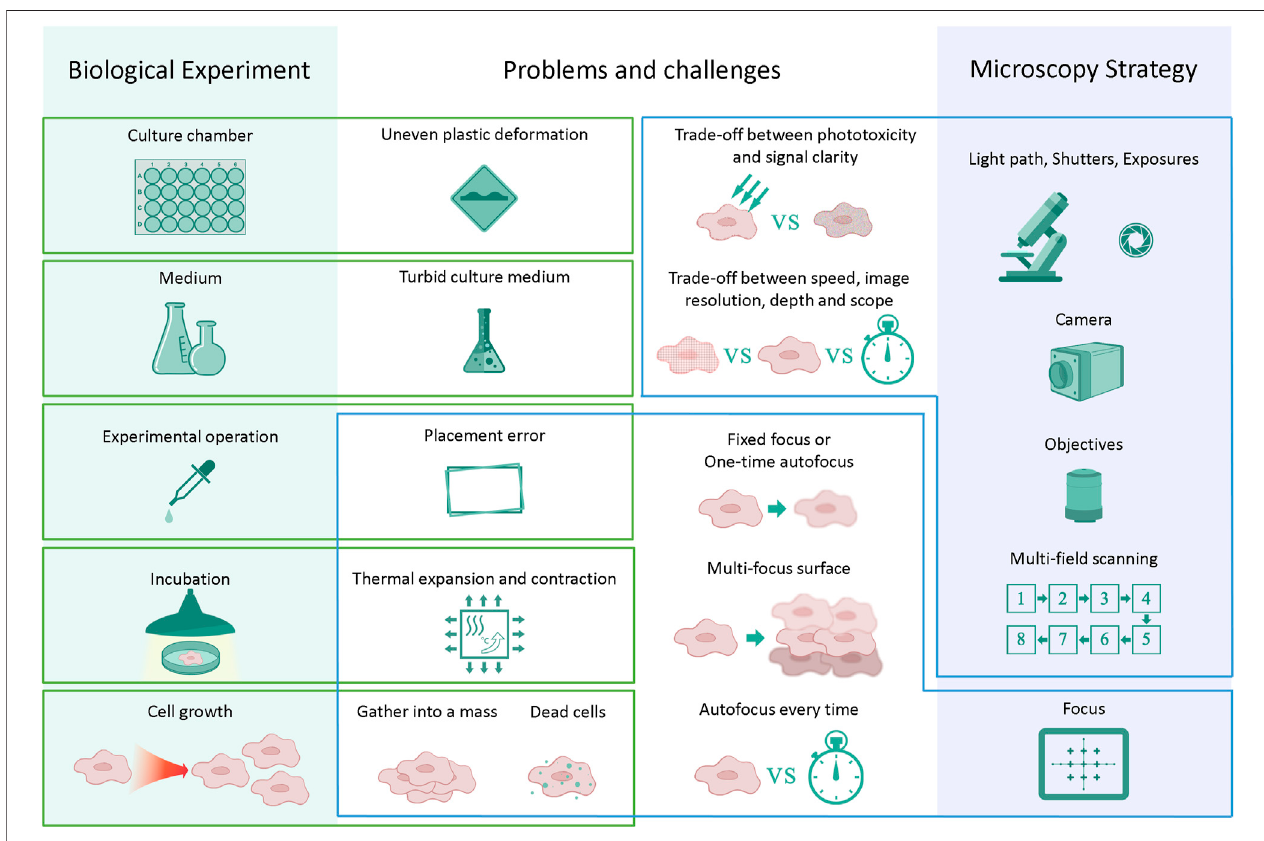
FIGURE 2 | Challenges in long-term live-cell imaging. Changes in individual steps or components may in fl uence the next series of steps and cause a reduction in image quality. Trade-offs must be made between time and image quality in almost every long-term experiment.